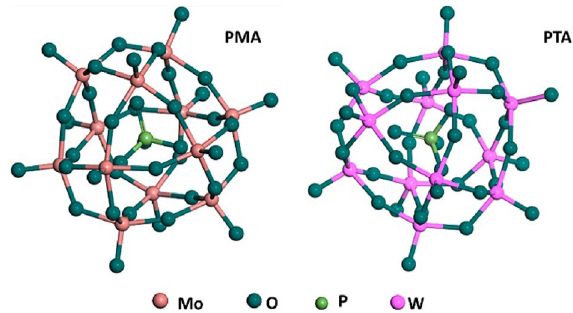
Figure 7. Optimized structures for PMA and PTA.